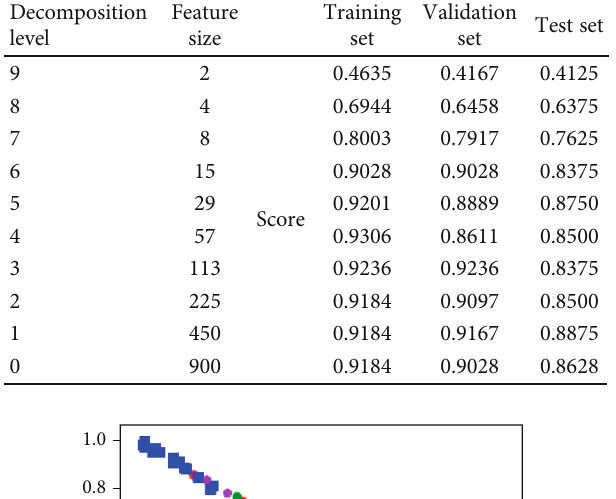
Table 1: The sensitivity analysis of the decomposition level for the SVM models. The original features consist of 900 data: 400 oil production rates, 400 water cuts, and cumulative 50 oil and 50 water productions.